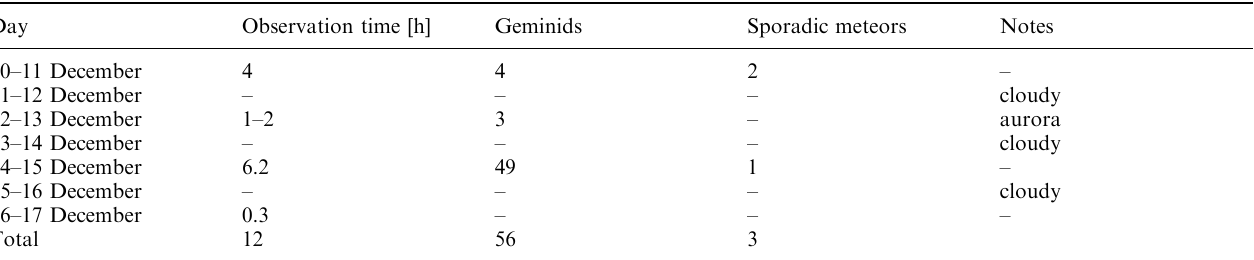
Fig. 2. EISCAT-UHF raw elec- tron density time series versus altitude showing both meteors and weak auroral activity. The time series show the instanta- neous raw electron densities of the ionosphere at each gate. The mean values over the 20-min periods are shown in the right- hand column . The vertical line at the right shows the dynamical range of the densities